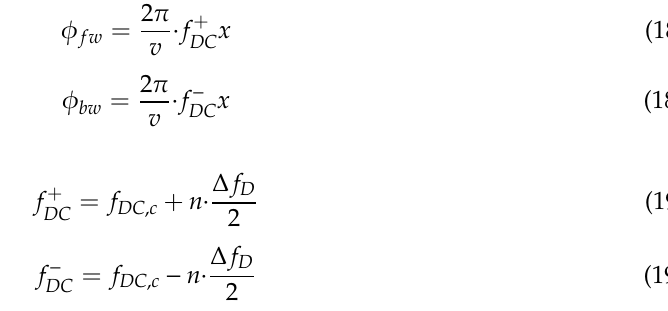
geometries. Forward- and backward-looking apertures are produced by the split beam process.